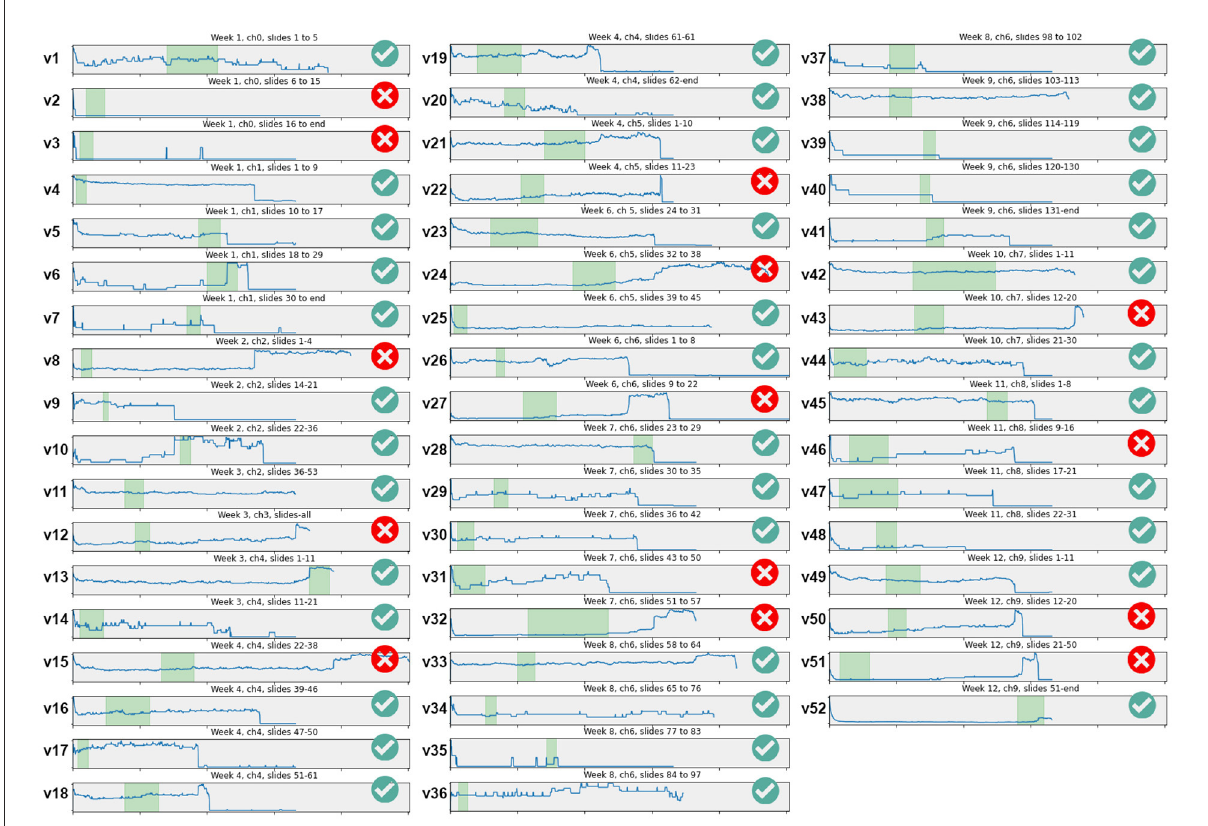
FIGURE3 Within-video playback usage for each of the 52 videos using the playback weighting strategy (without decay function), each video labeled v1–v52. In each graph, x-axis is video duration, y-axis is a normalized overall playback score for each second. In each video, highlighted in light green is the most important part in the video; X or × symbols indicate whether the highest plateau covers the most important part (i.e., students watched the important part) or